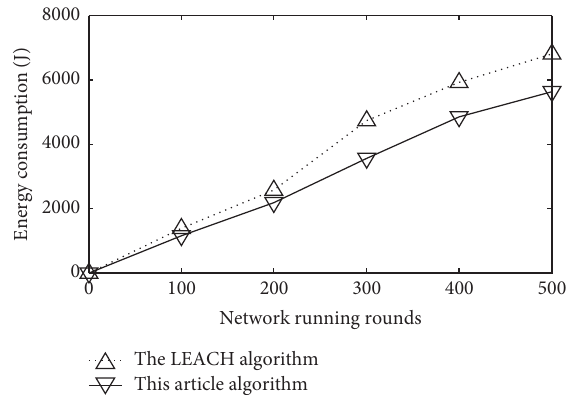
Figure 10: Energy consumption comparison in this article’s al- gorithm and the LEACH algorithm under different network running rounds (when s � 0.3).